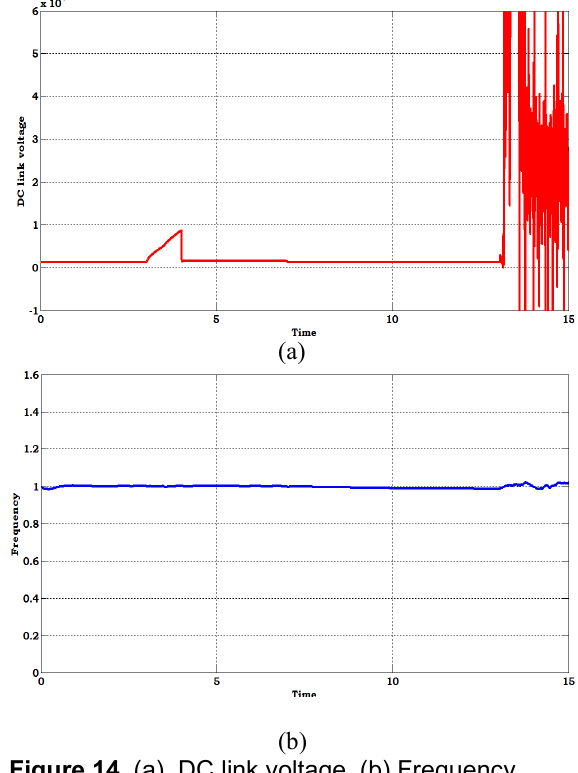
Figure 14. (a). DC link voltage, (b).Frequency Test Case 7: When operating system in islanded